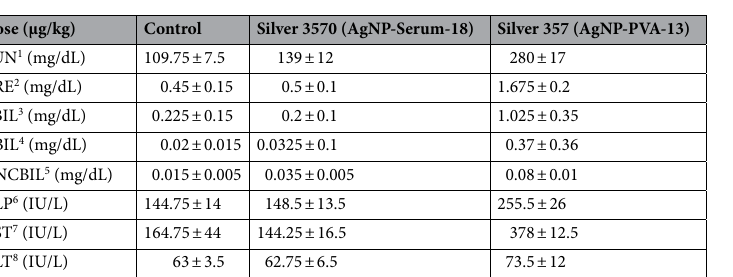
Table 1. Serum biochemical values of Swiss albino male mice after 4 weeks of AgNPs administration (n = 4). 1 blood urea nitrogen; 2 creatinine; 3 total bilirubin; 4 conjugated bilirubin; 5 unconjugated bilirubin; 6 alkaline phosphatase; 7 aspartate amino transaminase; 8 alanine amino transaminase. All data were presented as the mean ± SEM. Data were subjected to statistical analysis using one-way ANOVA with GraphPad Prism 8.0.2(263). Mean values were considered to be statistically significant at P < 0.05.